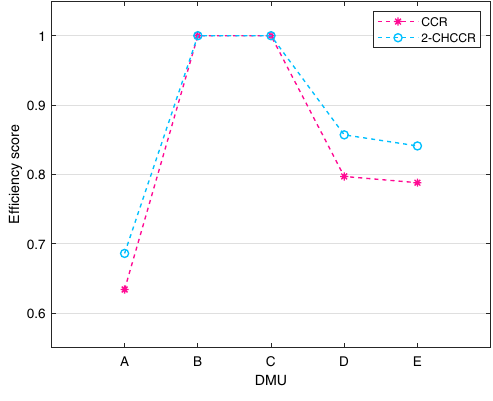
Fig. 1 Efficiency scores for CCR and 2-CHCCR